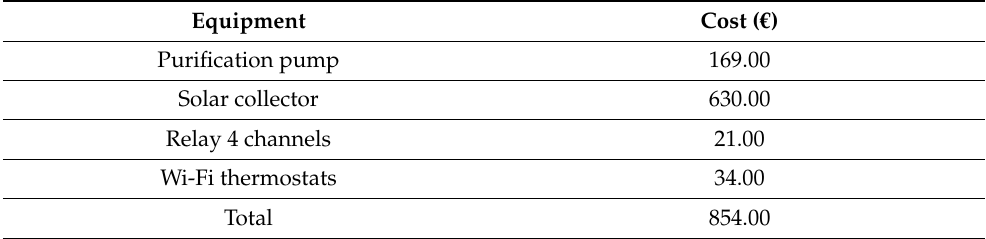
Table 6. Cost of installed equipment scenario